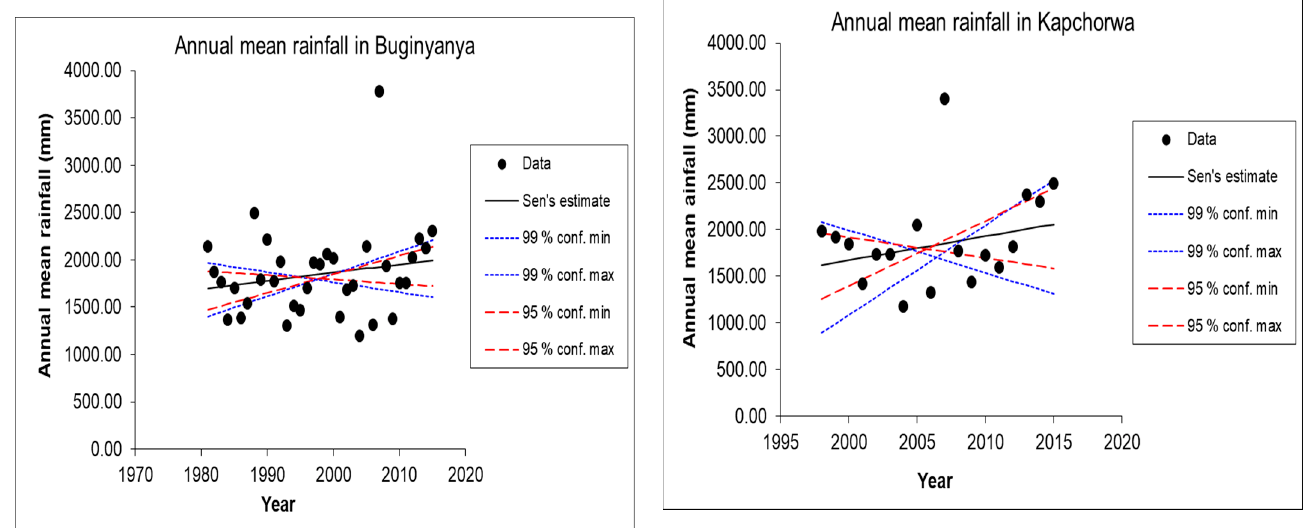
Figure 8. Time series of annual rainfall in Buginyanya and Kapchorwa (1981–2015).